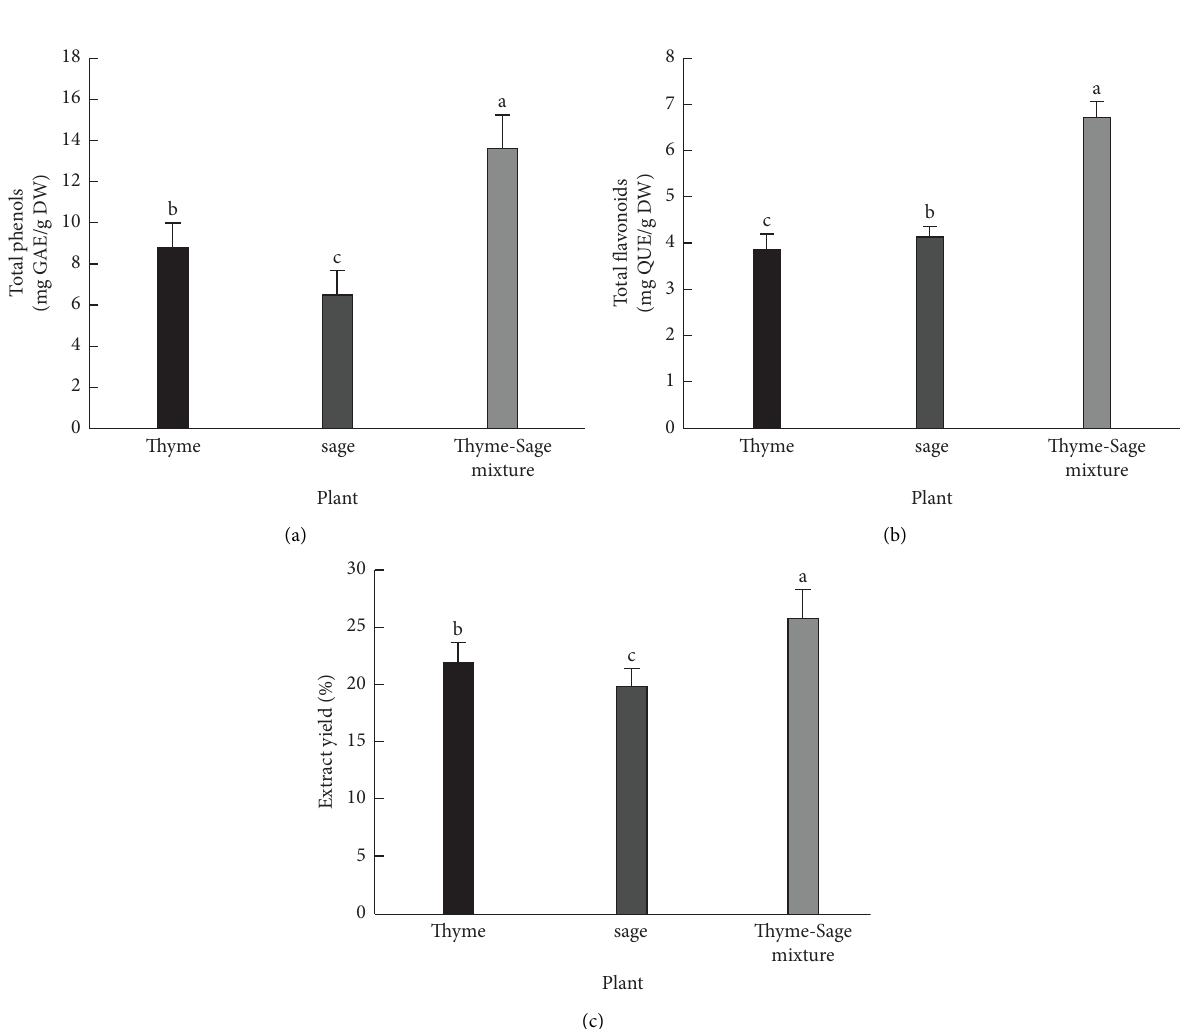
Figure 1: Total phenolic (a) and favonoid contents (b), and extract yields (c) of thyme, sage, and thyme–sage mixture. Results are means ± standard deviations ( n �